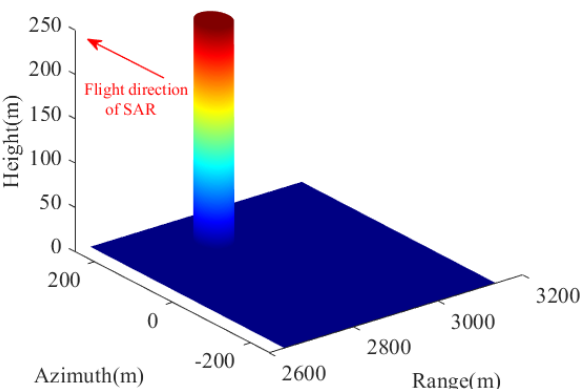
Table 1. Basic SAR system parameters for experiments in Figure 9.